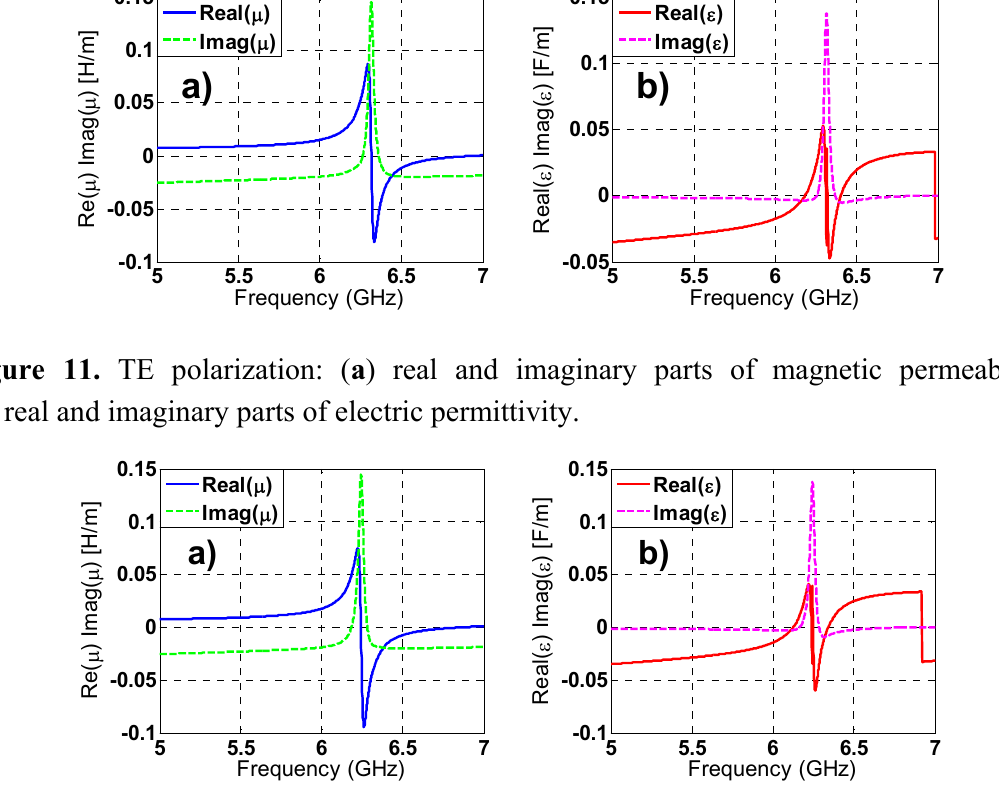
Figure 12. TM polarization: ( a ) real and imaginary parts of magnetic permeability; ( b ) real and imaginary parts of electric